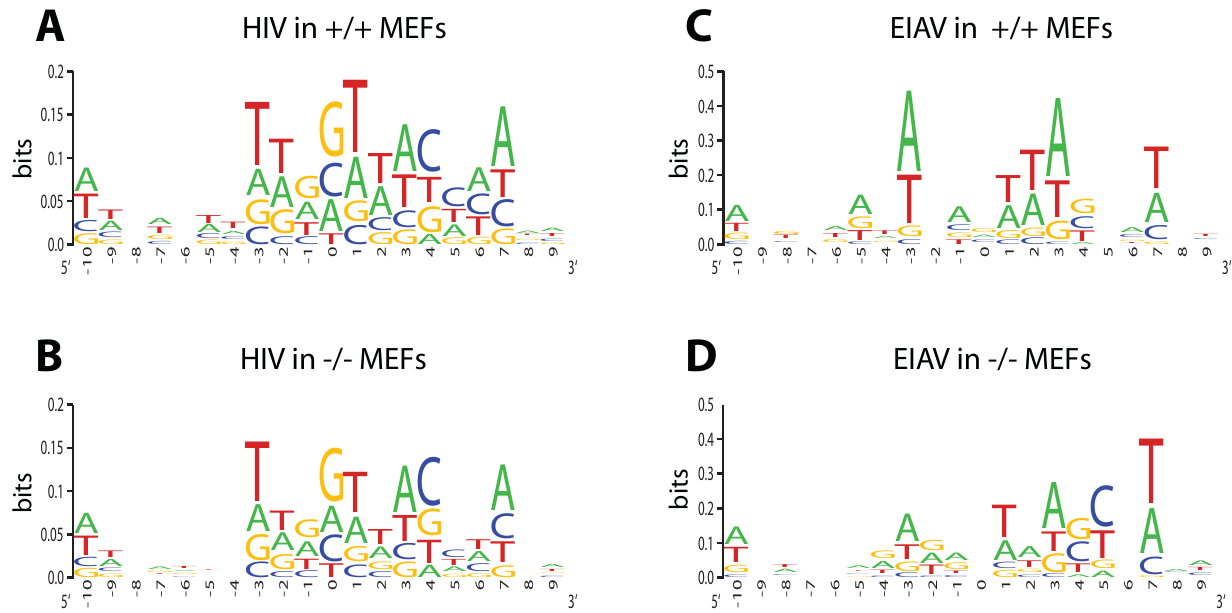
Figure 6. Integration site consensus sequence for lentiviral infection of murine control andLEDGF/p75-disrupted cells. A) HIV in + / + MEFs. B) HIV integration in 2 / 2 MEFs. C) EIAV integration in + / + MEFs. D) EIAV integration in 2 / 2 MEFs. Markings as in Figure 3.